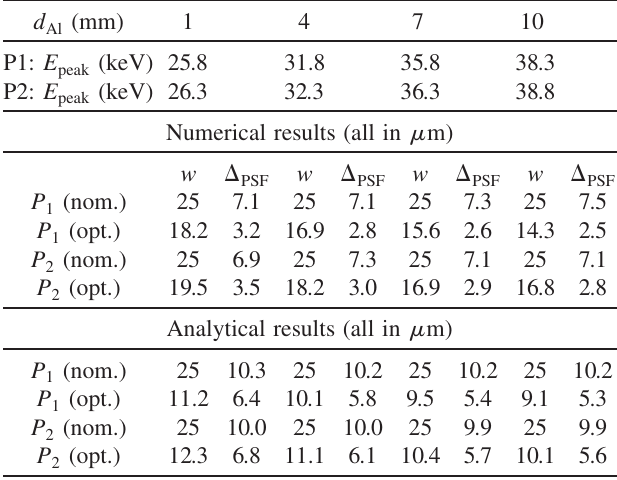
TABLE I. FWHM/2.35 of the PSF of the x-ray pinhole (cid:2) PSF , given by the Fresnel expression (8), for the nominal (nom.) and optimum (opt.) slit apertures w , and for several Al filter lengths d Al , at pinhole 1 and pinhole 2; and comparison with the analytical expression (rms) given by (2) and